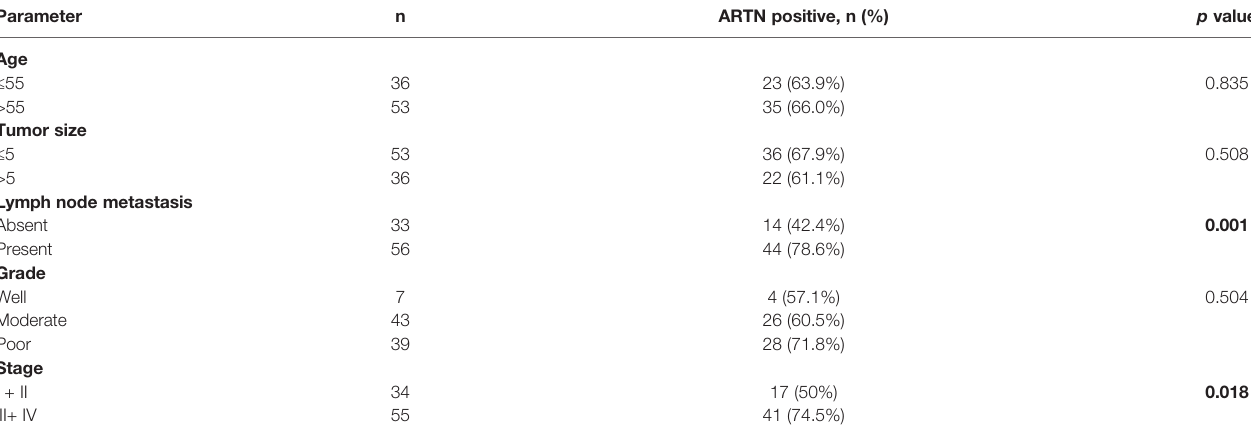
TABLE 2 | Correlation between clinicopathological parameters and ARTN expression in a CRC patient cohort.